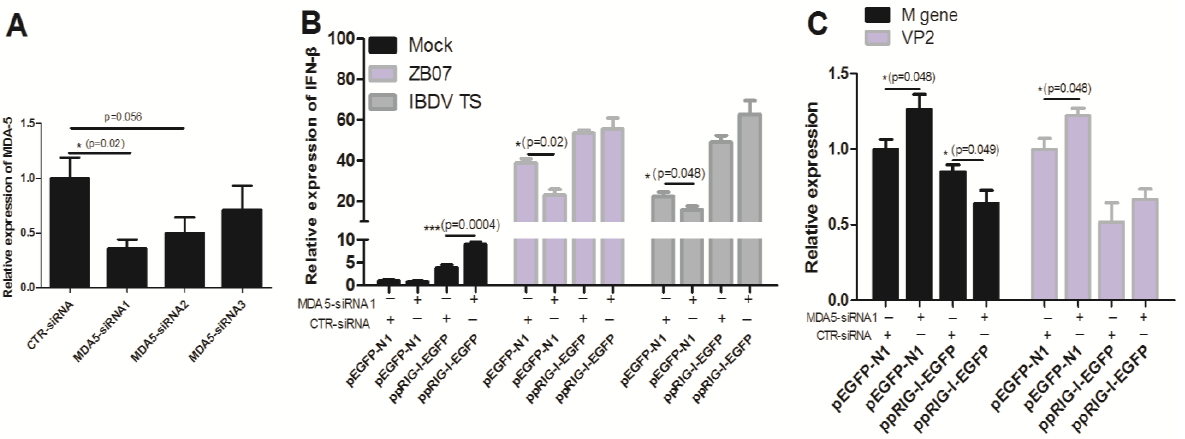
Figure 8. Effect of pRIG-I transfection on IFN synthesis in MDA5-knockdown DF-1 cells. ( A ) siRNA targeting chicken MDA5 and negative control siRNA were transfected into DF-1 cells. Then, 36 h later, the interference efficiency was measured by qRT-PCR; ( B , C ) DF-1 cells were co-transfected with pigeon RIG-I/pEGFP-N1 and MDA-siRNA/control siRNA (CTR-siRNA), and 36 h later, the transfected cells were infected with IBDV and ZB07 or mock-treated (MOI = 1). qRT-PCR was performed on extracted RNA at 8 h p.i. Data represent mean ± SEM from three wells per group. * p ≤ 0.05 vs. CTR-siRNA; ** p ≤ 0.01 vs. CTR-siRNA; *** p ≤ 0.001 vs. CTR-siRNA. Results are representative of two independent experiments.